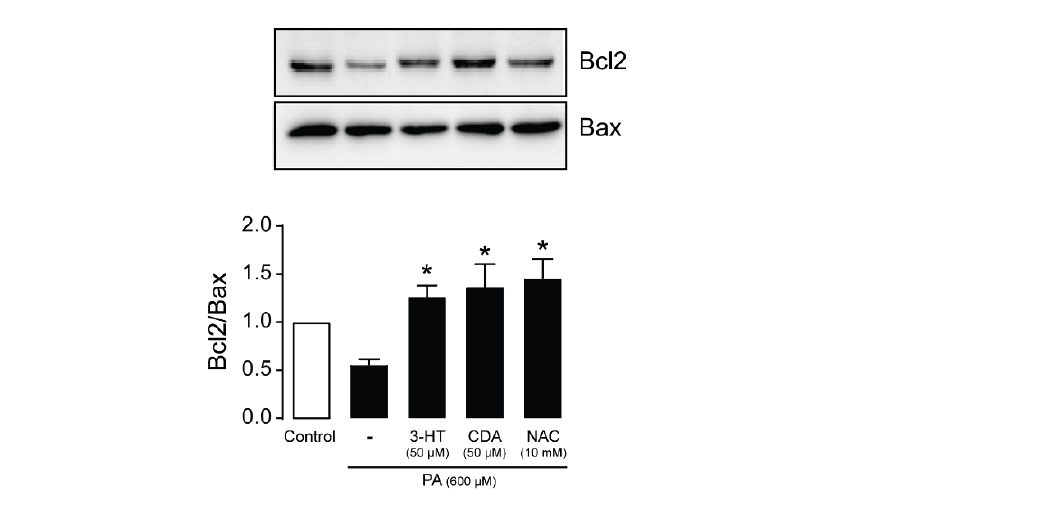
Figure 8. 3-Hydroxyterphenyllin (3-HT) and candidusin A (CDA) upregulate the anti-apoptotic Bcl-2 protein. Podocytes were cultured in 6-well plates and then incubated with 600 µ M palmitic acid (PA) in the presence or absence of 50 µ M 3-HT or CDA for 24 h. N -acetylcysteine (NAC) (10 mM) was used as a positive control. Western blot analysis was performed ( n = 6). The data are expressed as the band intensity of Bcl2/Bax ( n = 6). * p < 0.05 compared with the PA-treated group.